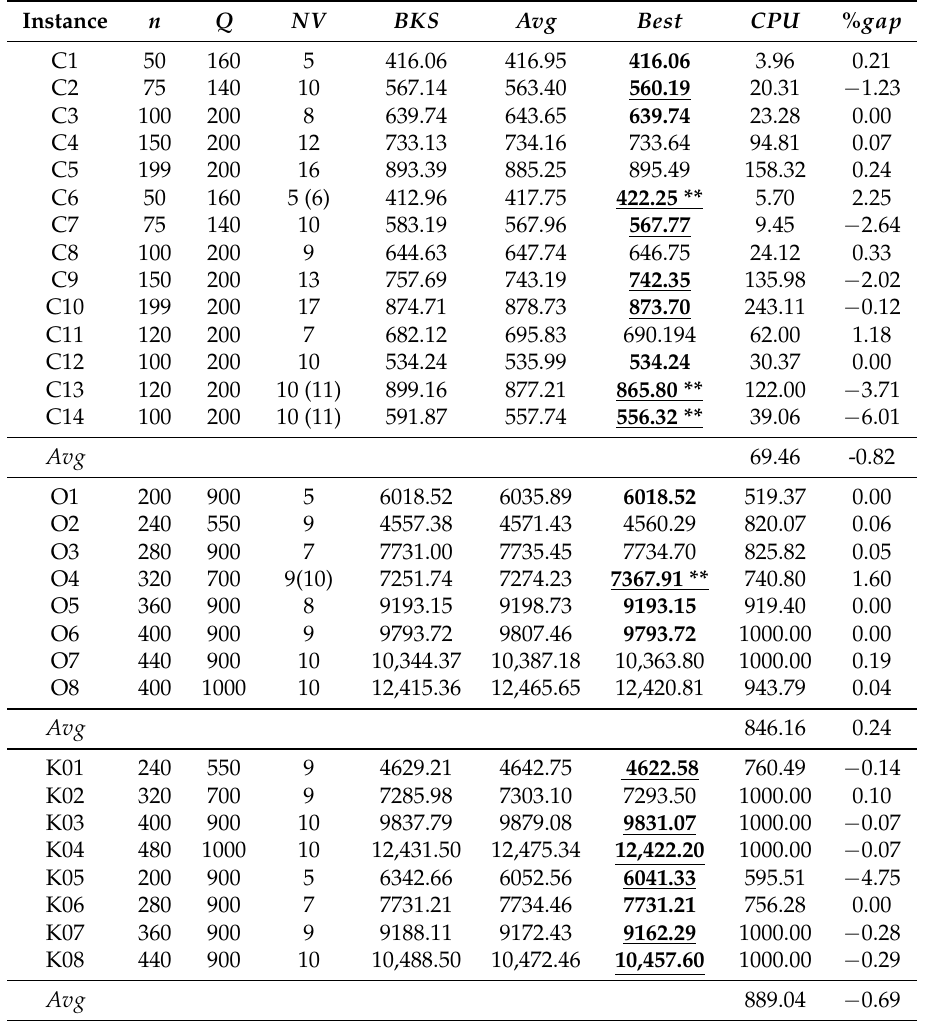
Table 2. Results obtained by the HGOALS for all the test instances (hierarchical objective